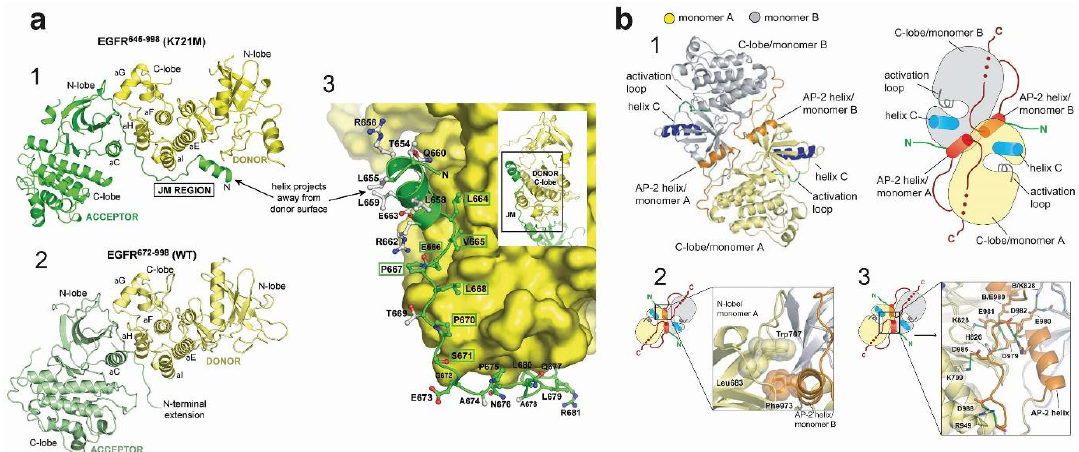
Figure 5. Asymmetric and symmetric kinase dimers showing interactions with the juxtamembrane (JM) and C-terminal domains. ( a ) Crystal structure of the EGFR kinase from residue 645 to 998, including the entire inner JM region and some 40 residues of the C-terminus. The structure shows that the C-terminal half of the JM of the receiver cradles the C-lobe of the activator, thereby stabilising the asymmetric dimer. (1) shows the structure with an inactivating K721M mutation, closely resembling the structure for EGFR lacking the JM region (2). (3) shows the detail of the side-chains in the acceptor JM region (green), in contact with the C-lobe of the donor kinase domain. Taken, with permission, from Red-Brewer et al. [179]. ( b ) Structure of the symmetric inactive dimer. (1) gives an overview of the structure, while (2) shows the hydrophobic packing between the C-terminal AP-2 helix and the N-lobe of monomers A and B, respectively. (3) shows the electrostatic hook that forms between the C-terminal tail of EGFR and the hinge region of its kinase domain. Taken, with permission, from Jura et al. [177].